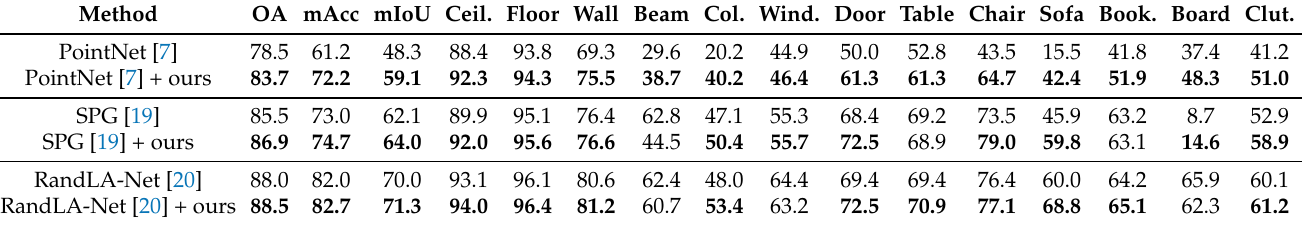
Table 5. Quantitative comparison between the semantic segmentation results of PointNet [7], Su- perPoint Graph [19], RandLA-Net [20], and ours on the S3DIS dataset [24] using six-fold cross